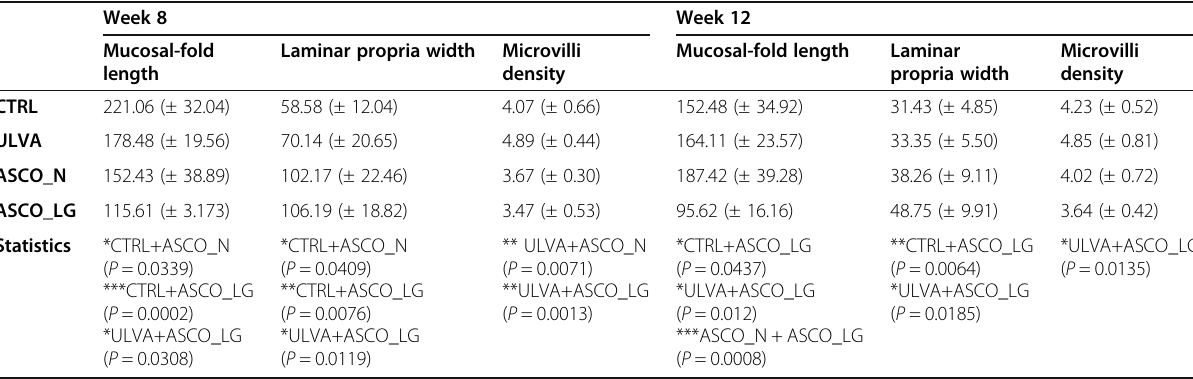
Table 1 Gut morphology from hindgut sections taken from juvenile Atlantic cod ( Gadus morhua ) from the CTRL, ULVA, ASCO_N and ASCO_LG groupings at Week 8 and Week 12. Mucosal-fold length ( μ m) and laminar propria width ( μ m) measurements are taken from light microscopy images while the microvilli density (AU) measurements are taken from scanning electron microscopy images (± SD). The associated statistical measurements indicated are calculated from Kruskal-Wallis significance testing P < 0.05*, P < 0.01**, P <